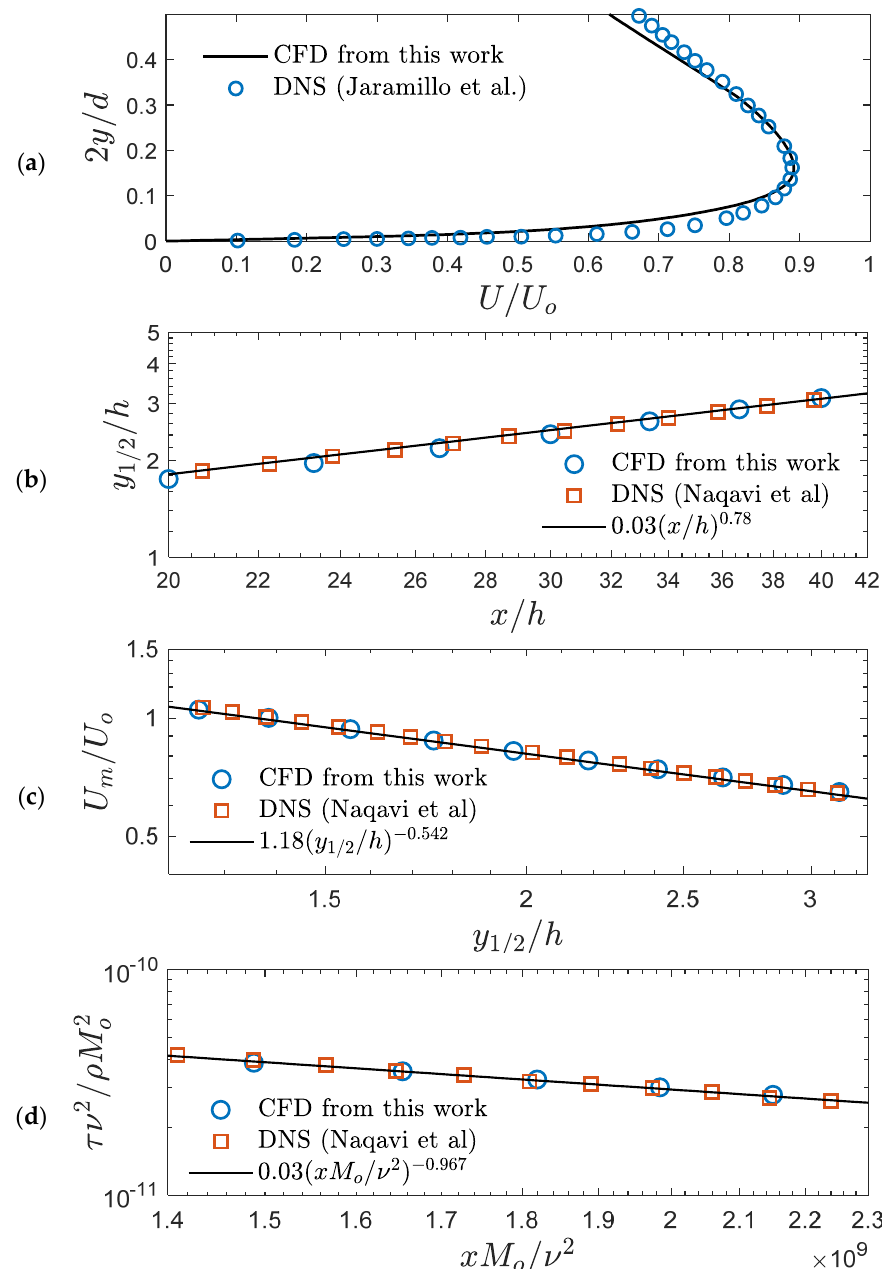
Figure 3. Validation of 𝒌 − 𝝎 SST for impinging jet modeling as shown originally in Fillingham et al. [24]. ( a ) Comparison of the velocity profile at 8 jet widths downstream of impingement location against DNS from Jaramillo et al. [37]. Comparison with wall jet DNS simulation from Naqavi et al. [41] ( b ) Decay of half maximum velocity location. ( c ) Maximum velocity. ( d ) Wall shear stress.